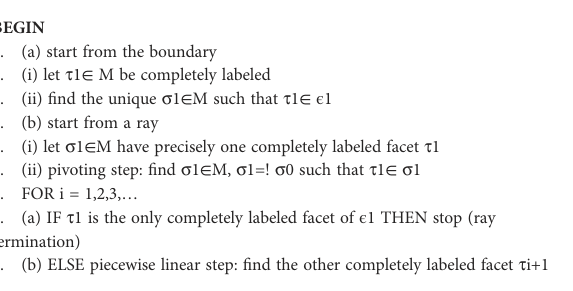
ALGORITHM 4 Piecewise Linear Transformation.